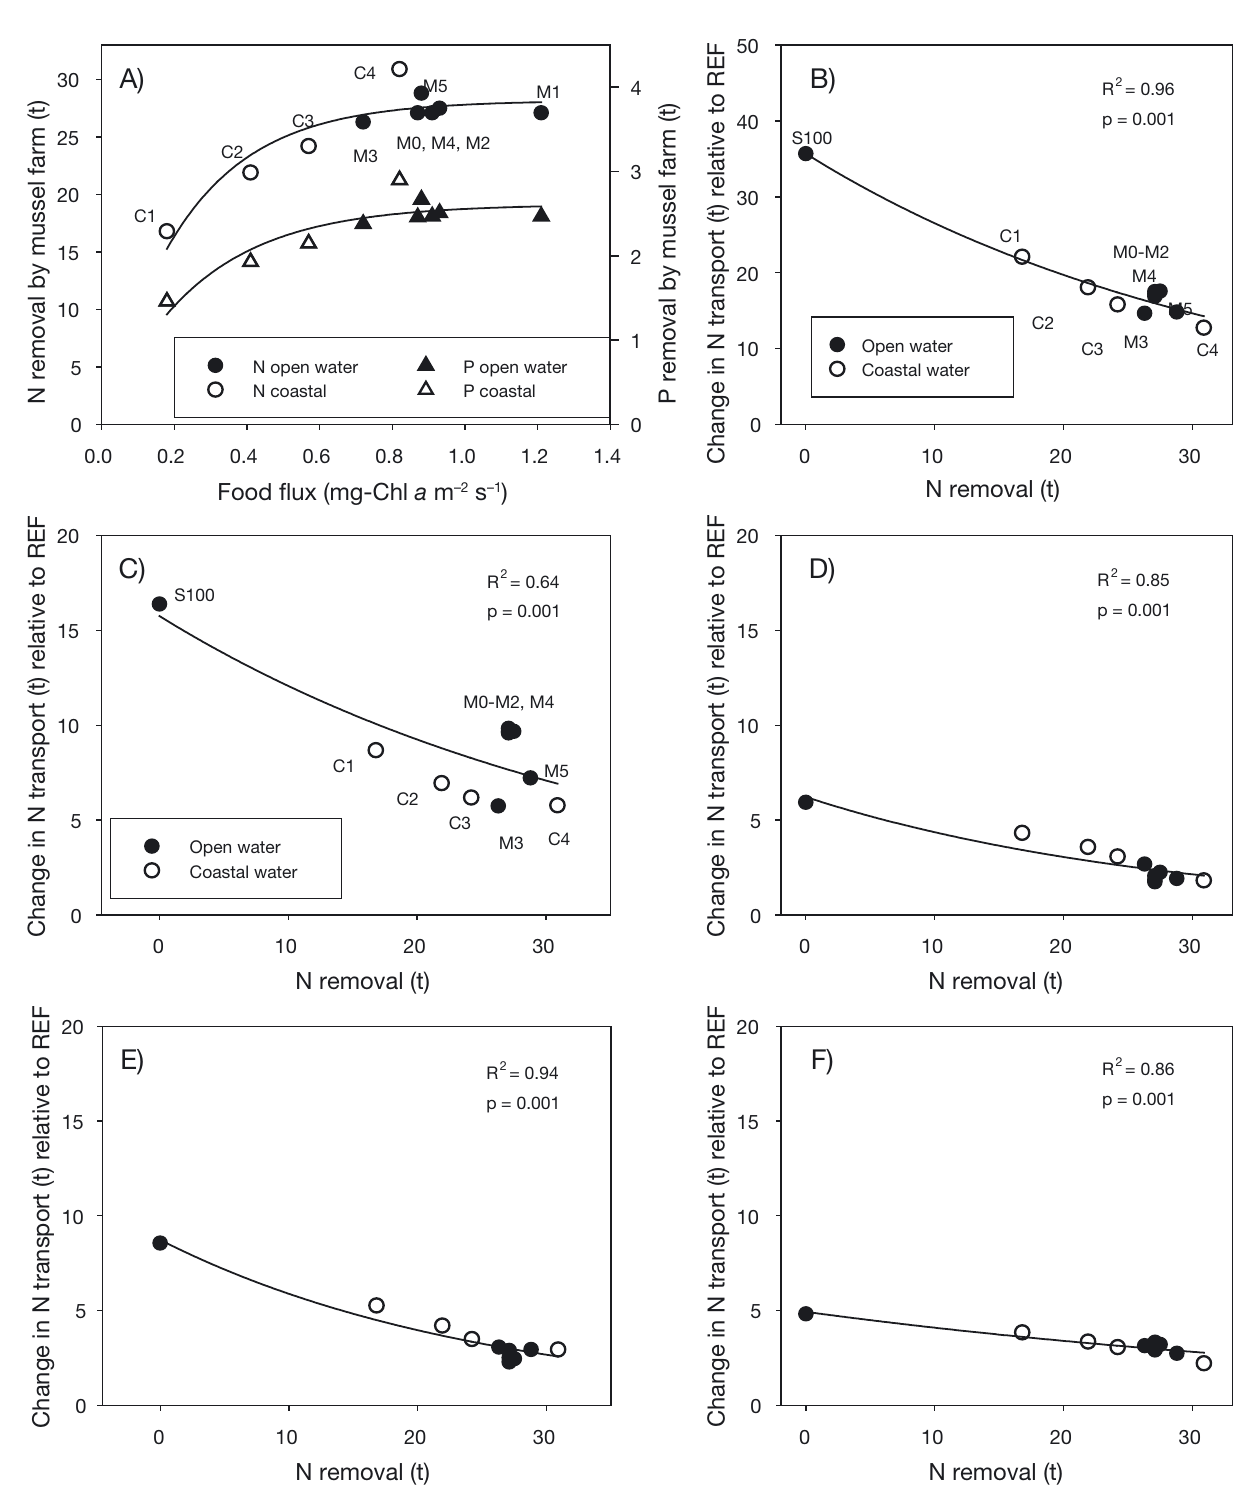
Fig. 6. (A) Total N and P removal per mussel farm by harvest as a function of food flux. (B−F) Change in gross N transport across different transects (see Fig. 2) relative to the reference scenario (REF): (B) all transects (1−11), (C) western coastal areas (Transects 1−5), (D) eastern coastal areas (Transects 6−9), (E) the Kattegat (Transect 10) and (F) the Great Belt (Transect 11) when adding a mussel farm into coastal areas (C1−C4) or open waters (M0−M5) to compensate for the fish farm nutrient inputs (S100). Scenario names are only indicated in panels A−C, but D−F follow the same pattern as